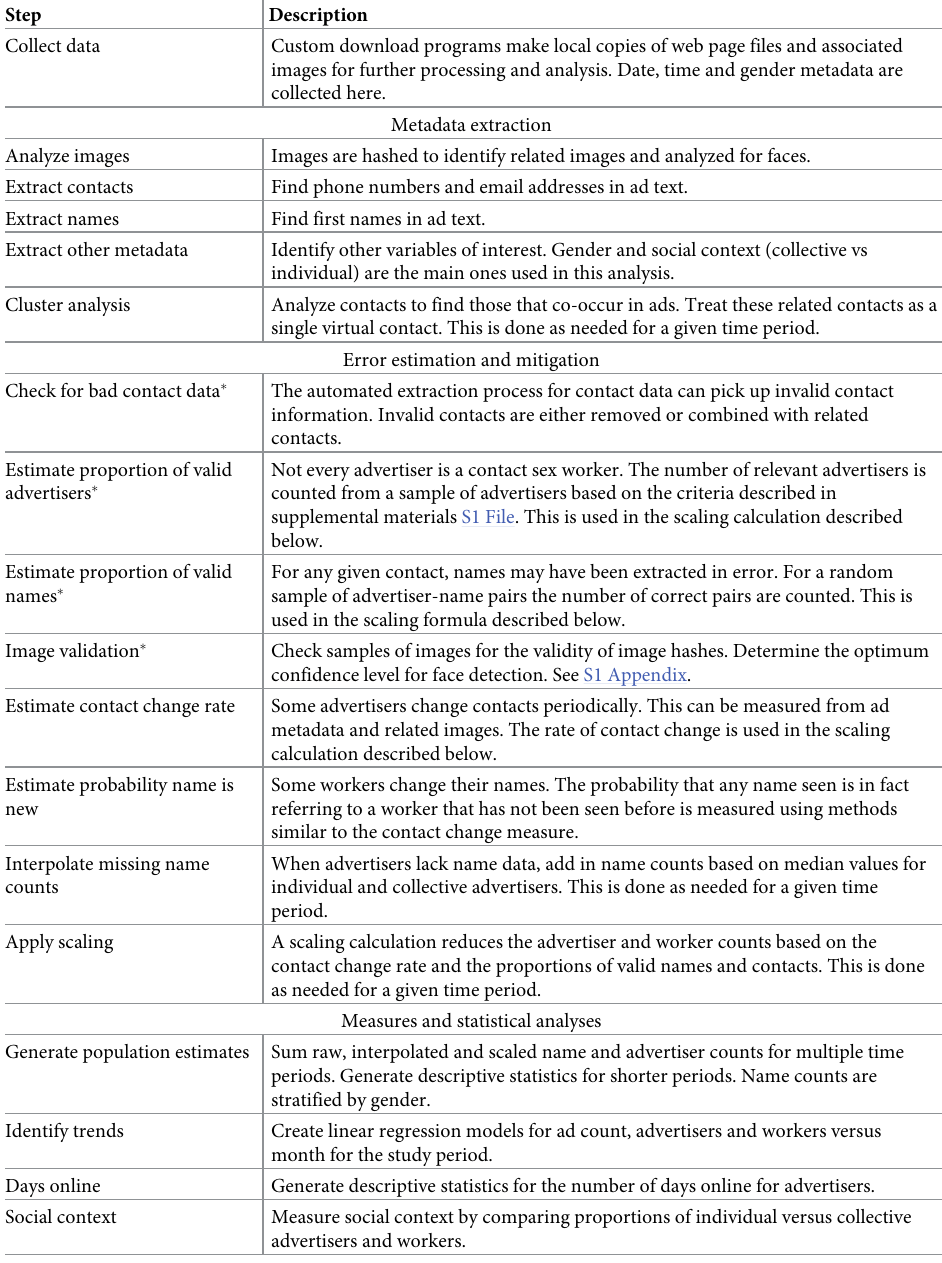
Table 1. Data processing steps for population estimation. Steps were automated except where